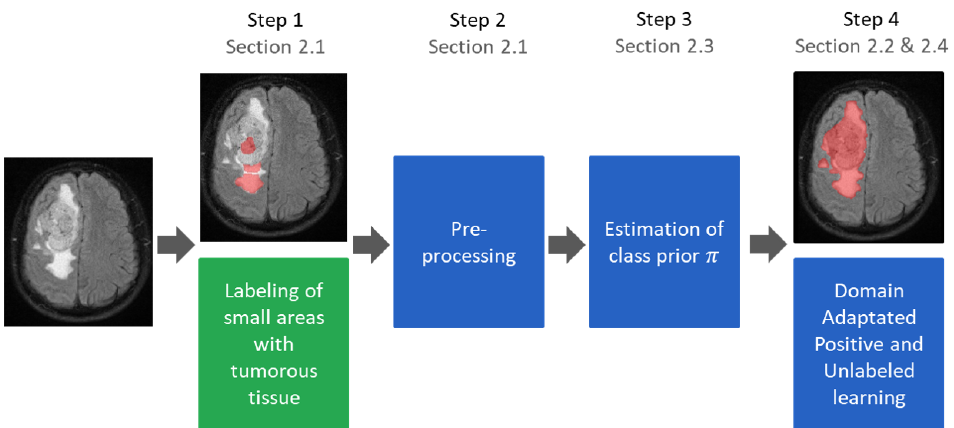
Figure 1. Training workflow of the proposed segmentation algorithm with sparse positive annotations only. Except for step 1, all steps can be fully automated. The trained classifier is identical to a classifier trained with conventional annotations and can be used without any manual interaction.